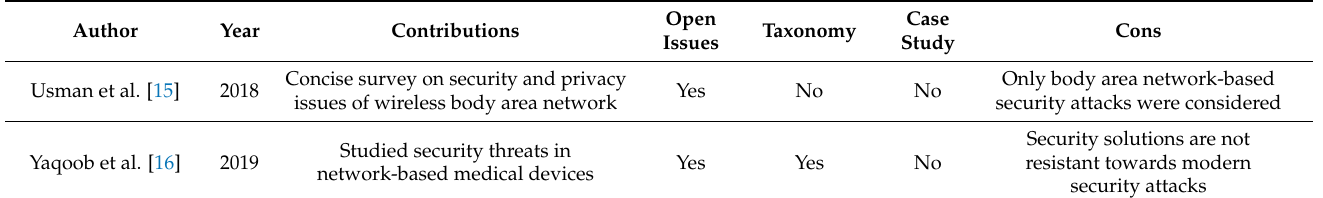
Table 1. Comparative analysis of the existing state-of-the-art studies and the proposed